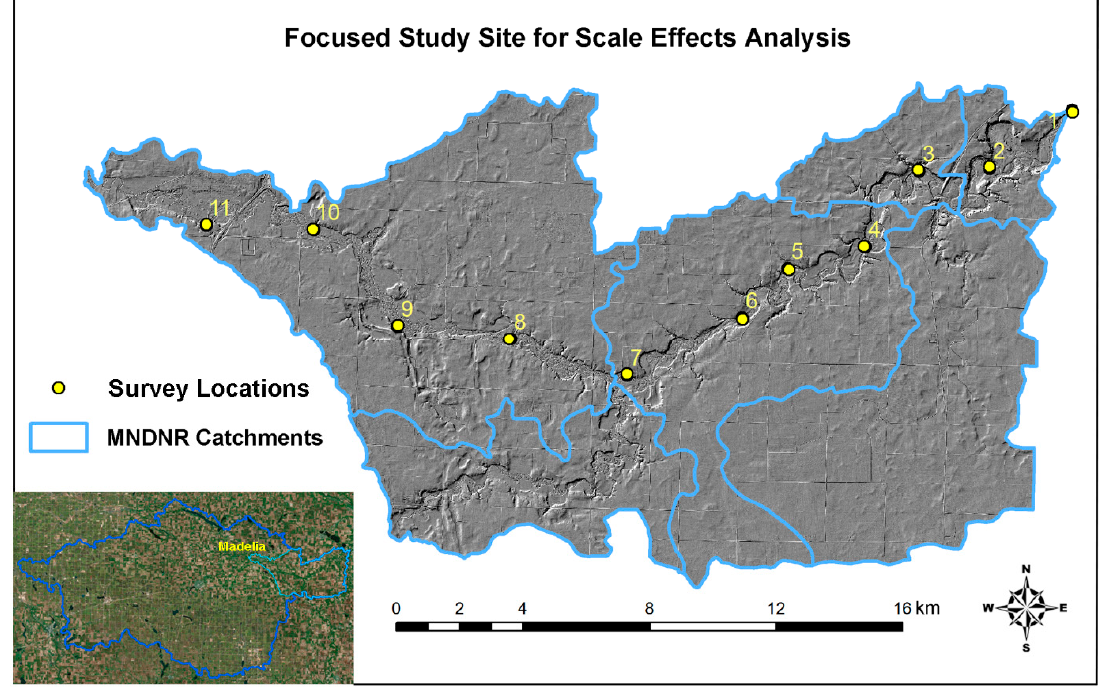
Figure 2. The six Minnesota Department of Natural Resources (MNDNR) catchments overlaid with a shaded relief map created from the Light Detection and Ranging ( LiDAR)-based 1-m DEM.